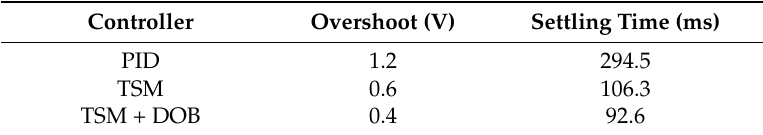
Figure 18. Experimental step ‐ load comparisons of the output voltage under PID, TSM, and TSM + DOB control modes.